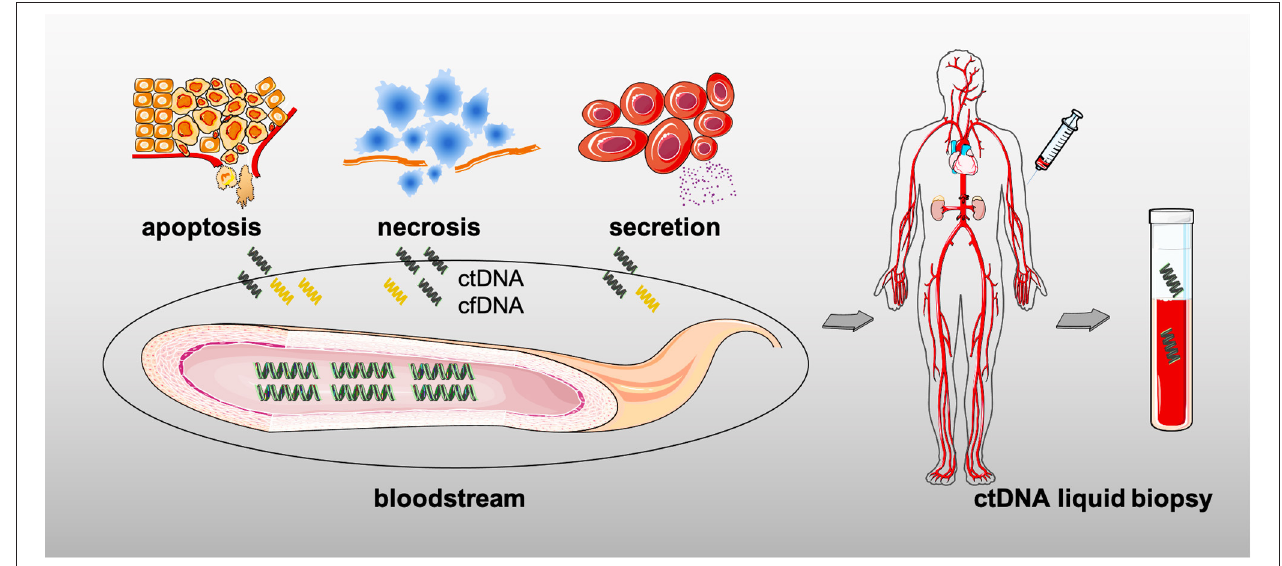
FIGURE 3 | The origins of circulating tumor DNA